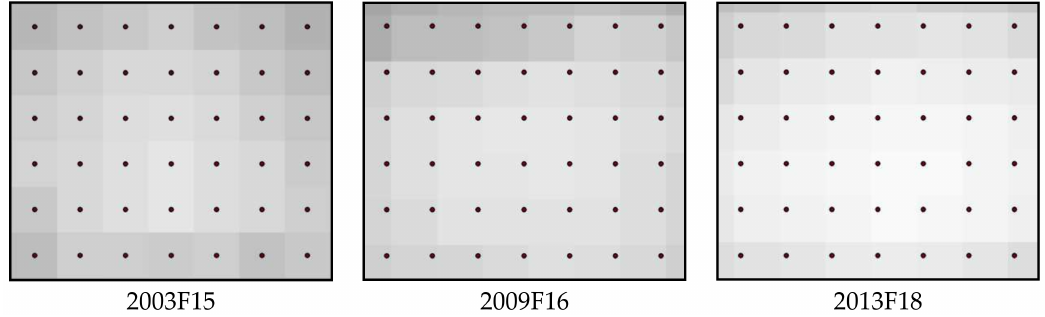
Figure 2. The registration error of the DMSP/OLS time series NTL images in the same region. The dot(s) represents the pixel center of the reference image, which is defined as an NTL image acquired by the F16 satellite in